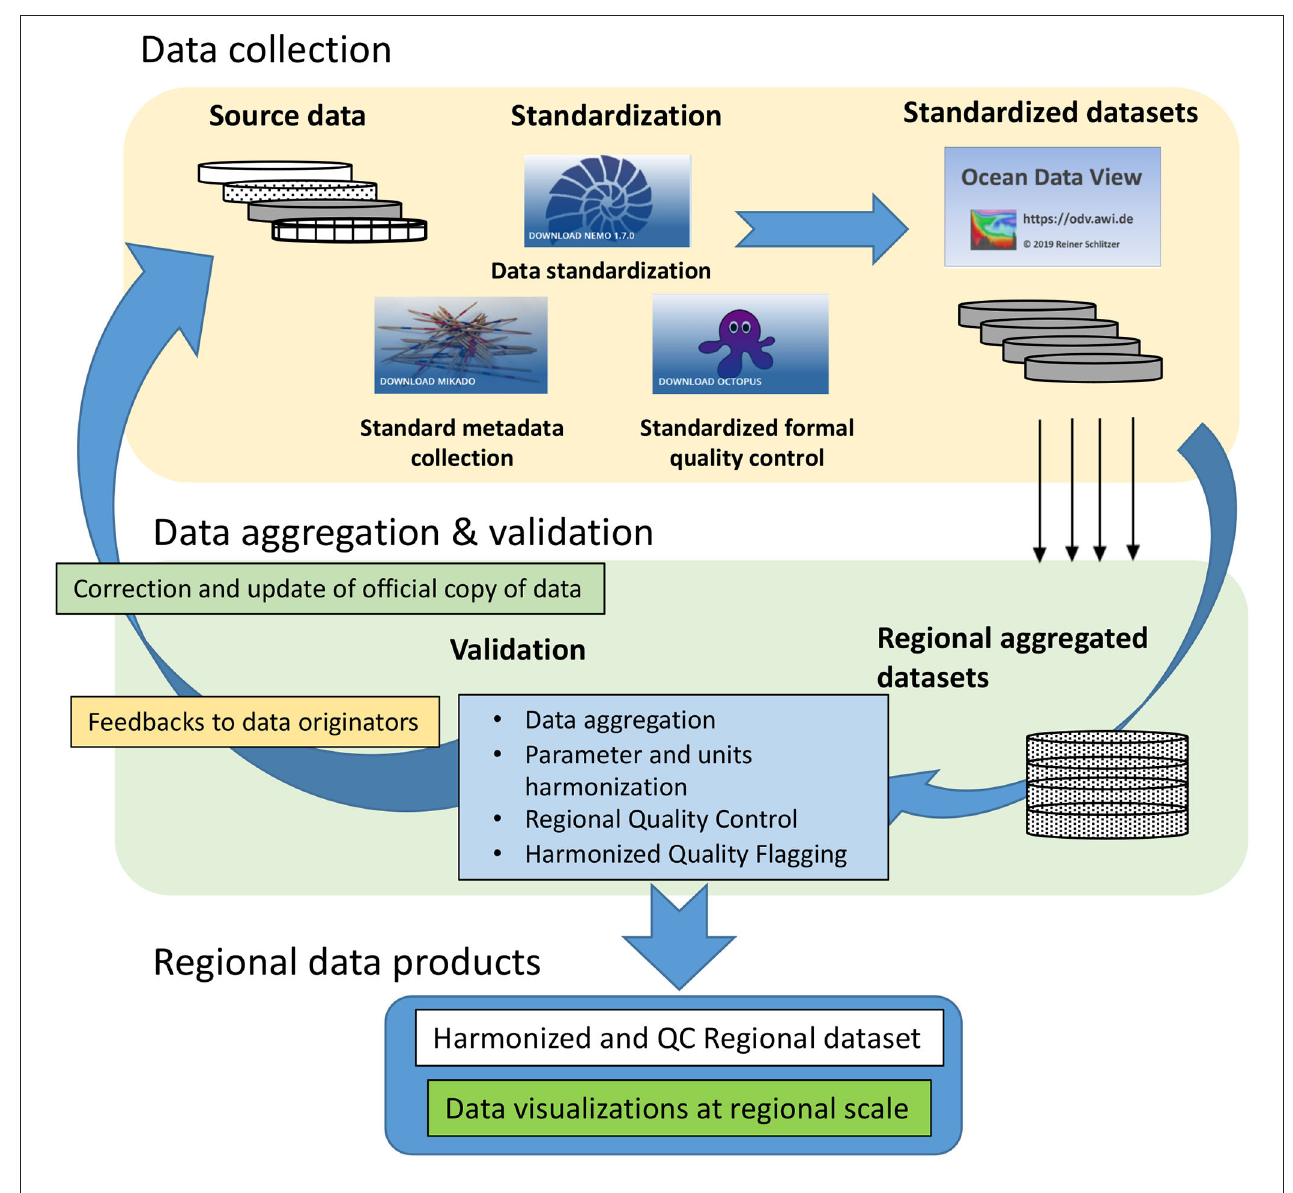
FIGURE 1 | The loop implemented within EMODnet Chemistry for data quality control, assures continuous data quality